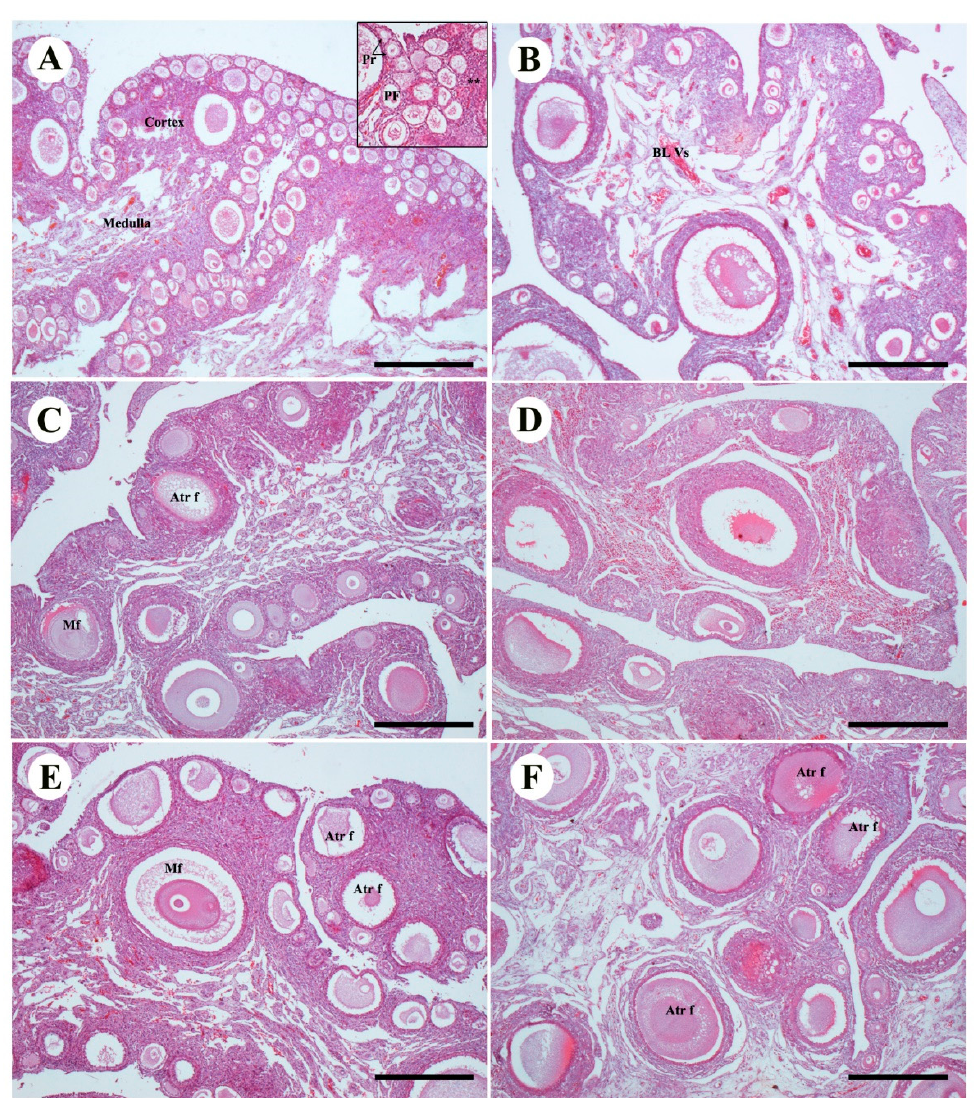
Figure 3. Effect of TAM treatment with different doses on ovarian structures of two bird strains ( A , B ): control group of Avian48 A and Arbor Acres B ovaries showing normal follicles of ovarian cortex, primordial follicle pr, primary follicle p and theca cells (astrix). ( C , D ): ovaries treated with Tam10 in Avian48 C and Arbor Acres D showing increase in the atretic follicles and decrease in the primary and primordial follicles. ( E , F ): ovaries treated with Tam20 of Avian48 E and Arbor Acres F showing different stages of atretic follicles. Atretic follicles Atr f, mature follicles Mf. H&E stain, scale bar 100 µm.